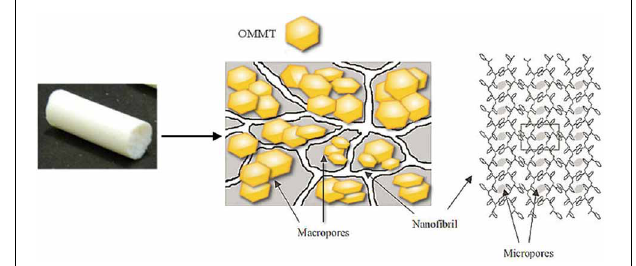
FIGURE 7 | SEM of aerogels with porosity P = 90%, having 80/20 polymer/OMMT weight ratio: (A,A (cid:3) ) with exfoliated OMMT; (B) with intercalated OMMT.